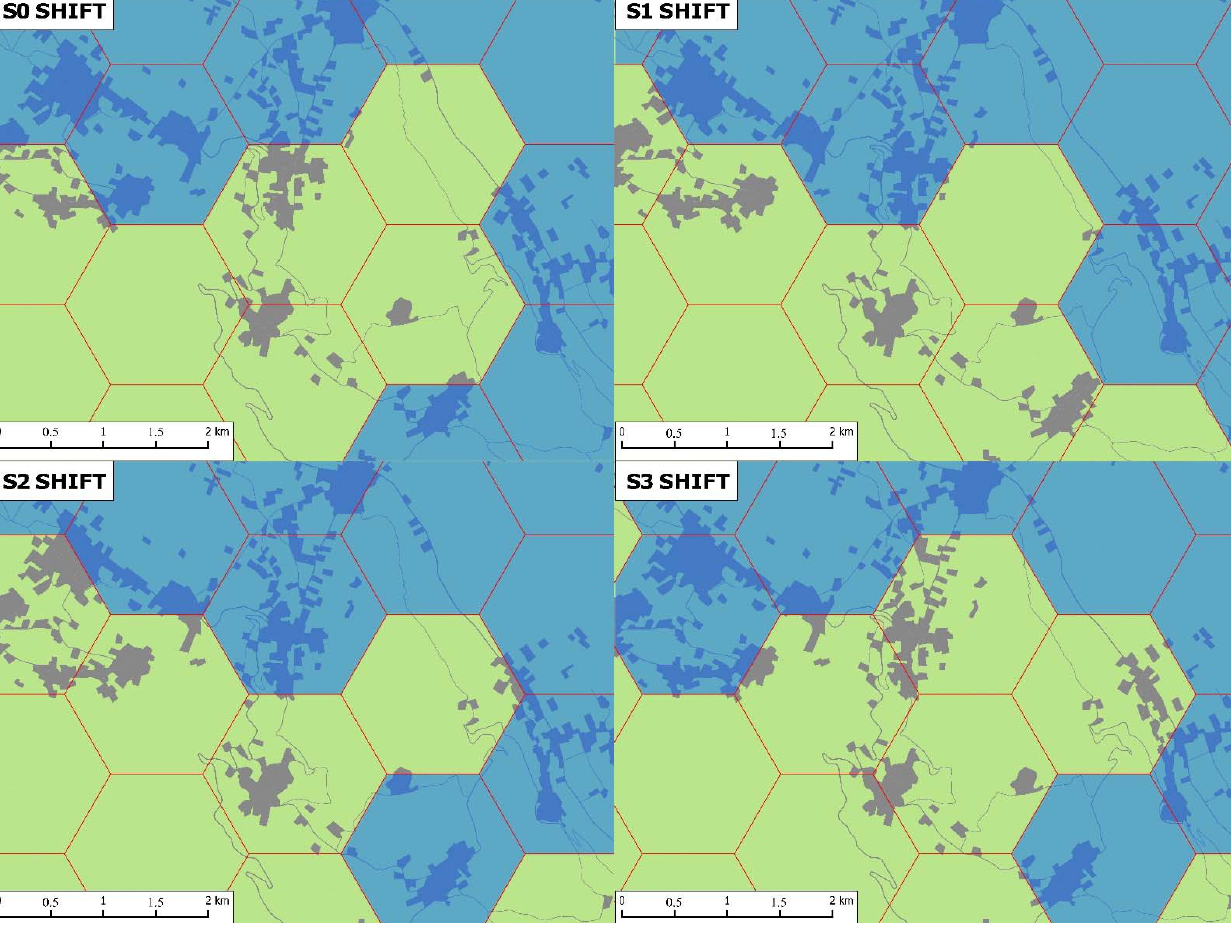
Figure 8. Benzene resonance structures [47].